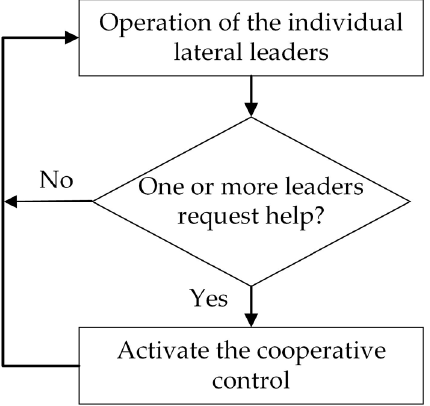
Figure 5. Combining individual and cooperative controls.